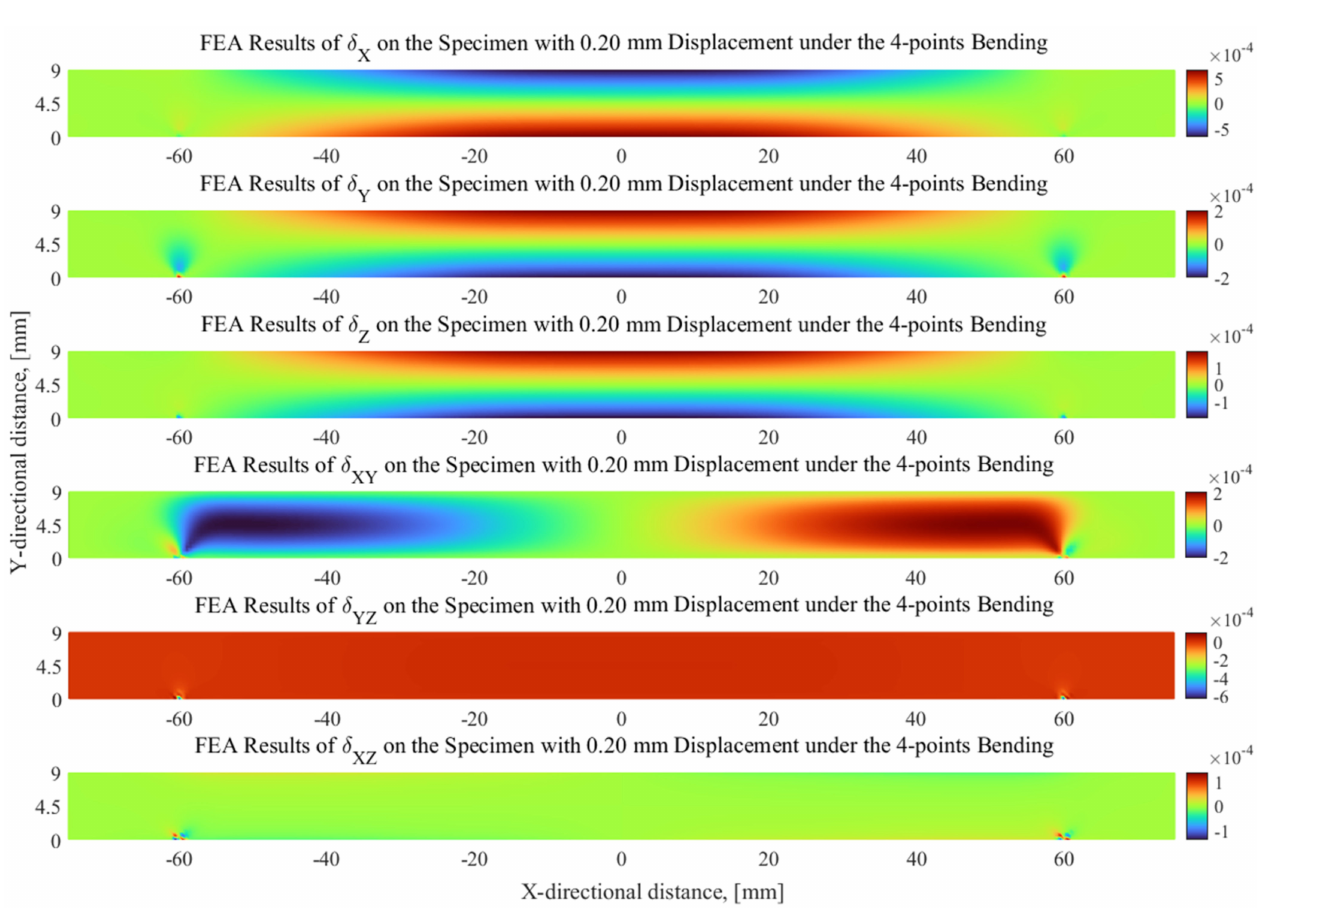
Figure 15. The results of numerical approach using FEA on structural simulation of 4-point bending test including deflection components in the x ( δ x , y ( δ x ), and z ( δ x ) directions and shear deflection in the xy ( δ XY ), yz ( δ YZ ), and xz ( δ XZ )